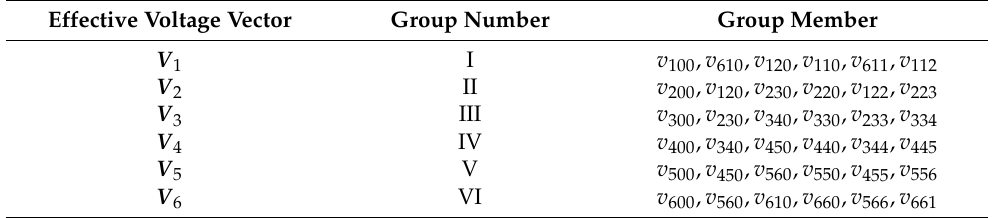
Figure 2. Preselection groups of candidate voltage vectors. Table 1. The members of preselection